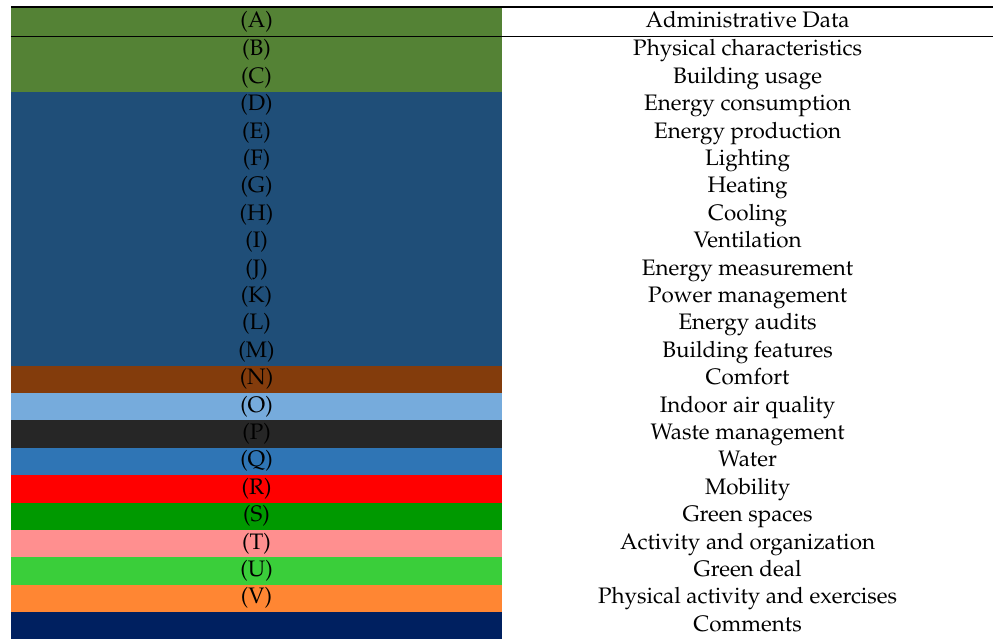
Table 1. Base-themes of SAVING’s